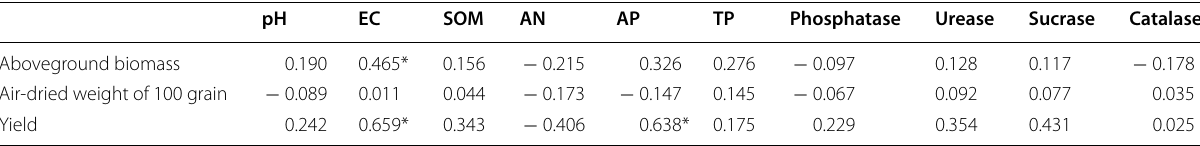
*means the significant correlation at P < 0.05. EC electrical conductivity, SOM soil organic matter, AN available nitrogen, AP available phosphorus, TP total phosphorus